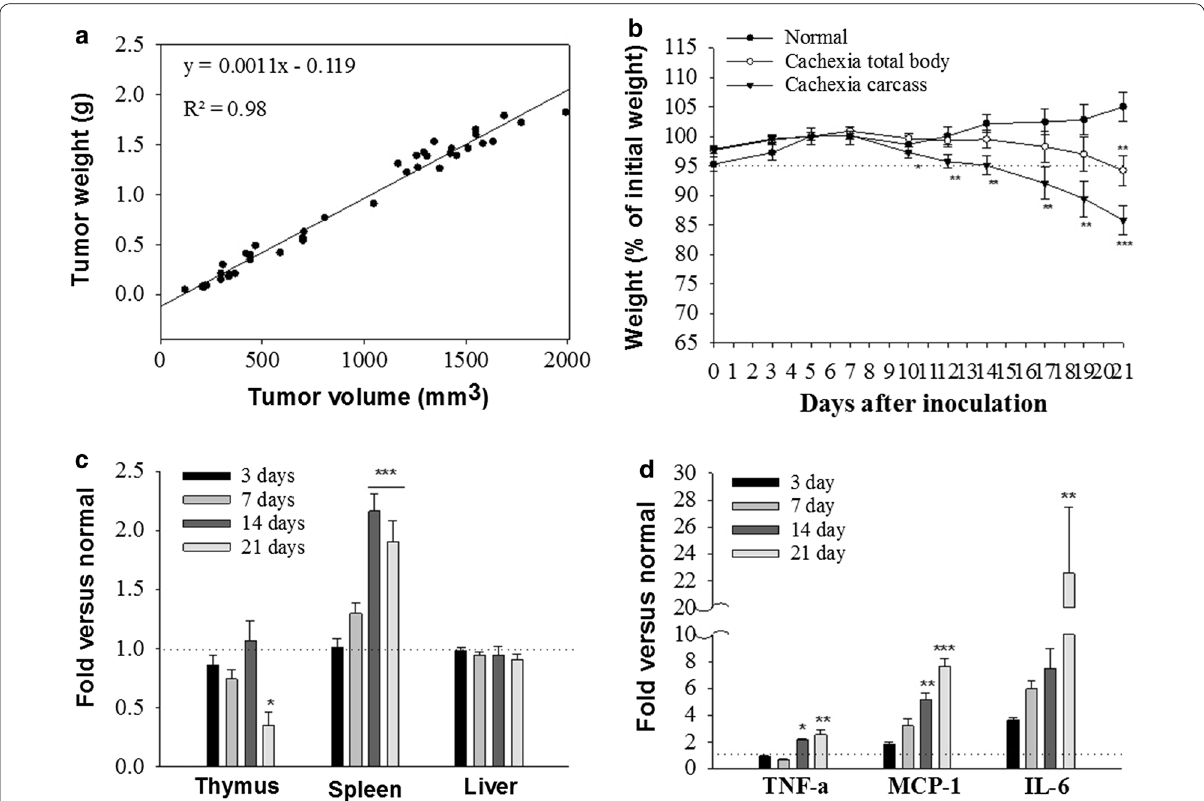
Fig. 3 Physiological changes during cachexia progression. For physiological characterization during cachexia progression, the total body, carcass, organs weights, and cytokine change were monitored at 3, 7, 14, and 21 days after C26 cell inoculation. a Using the equation for estimating tumor weight from tumor volume obtained from a previous study, b the graph indicates the percentage of total body and carcass weight with S.E.M in the normal and cachexia groups. Dotted lines indicate 5% weight loss, indicating the end of the pre‑cachexia stage. * P < 0.05, ** P < 0.01, *** P < 0.001 versus control. c The thymus, spleen, and liver were weighed. The bar graph represents fold‑change values in the cachexia group versus the normal group, with SEM. Dotted lines indicate the normal group fold‑change. ** P < 0.01, *** P < 0.001 versus 3 days after C26 cell inoculation. d Analysis of inflammatory cytokines during cachexia progression in blood serum samples. The levels of inflammatory cytokines were measured using an ELISA kit. The bar graph represents fold‑change values of the cachexia group versus the normal group with standard error of the mean. Dotted lines indicate the normal group fold‑change. * P < 0.05, ** P < 0.01, and *** P < 0.001 versus 3 days after C26 cell inoculation. IL, interleukin; TNF,